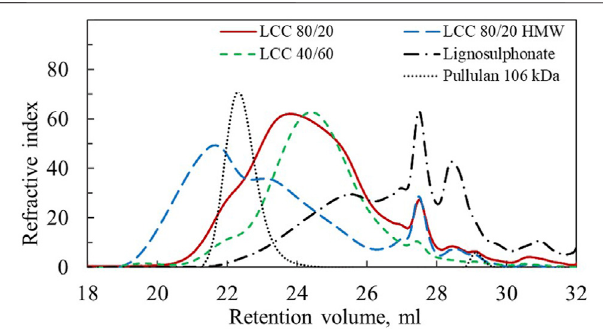
FIGURE 2 | SEC chromatograms for LCC 80/20, LCC 80/20 HMW, LCC 40/60, lignosulphonate and pullulan calibration standard with M w 106